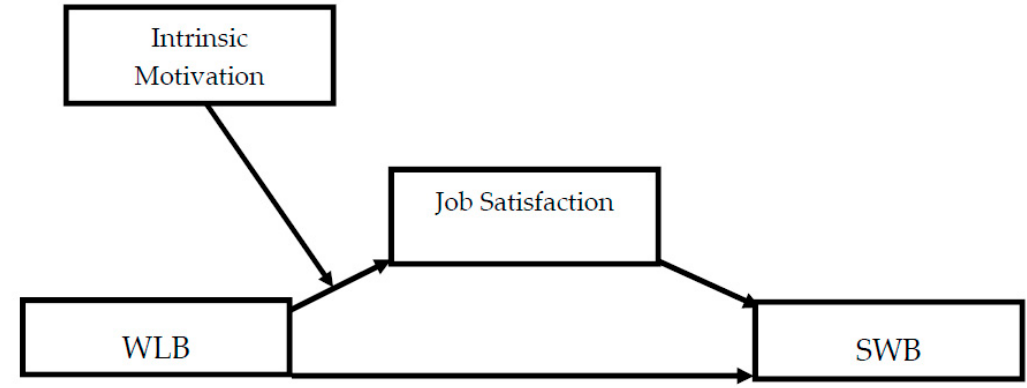
Figure 1. Theoretical Model (Source: Authors).